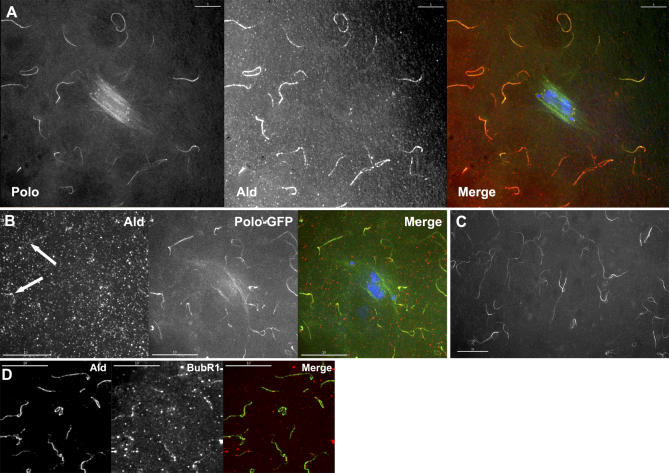
Polo and BubR1 Are Also Present in Ald-Containing Filaments(A) Polo-GFP/Ald colocalization A fixed oocyte from a polo-GFP homozygous female, showing that only Polo localizes along the meiotic tubulin spindle, while both Ald and Polo colocalize to kinetochores and along the cytoplasmic filaments. The chiasmate chromosomes appear slightly abnormal, possibly due to overexpression of Polo, but achiasmate X NDJ was no more than 1%–3% (our unpublished observations).(B) Polo-GFP still highlights filaments in ald mutant oocytes. A fixed oocyte from a polo-GFP/+; aldExc23 female. This ald allele greatly reduces, but does not eliminate, the dosage of wild-type Ald present (see Figure 5B). Ald staining is mostly in discrete foci, some of which are close enough together to be interpreted as filaments (arrows). However these filaments still contain Polo-GFP fluorescence, which appears undisturbed by the reduction in Ald dosage.(C) Unfixed Polo-GFP also highlights filaments GFP fluorescence from an unfixed polo-GFP oocyte, with filaments qualitatively similar to those seen in fixed images. Due to the lack of a DNA marker, the location of these filaments relative to the oocyte nucleus could not be determined, but based on Polo-GFP localization to the spindle (see Figure 6A), the oocyte nucleus does not appear to be in the imaged region.(D) BubR1 can also highlight filaments. In ten out of 33 FM7/X oocytes, BubR1 was found to weakly highlight some filaments visualized by Ald antibody. This figure represents the best staining observed; in most oocytes the staining was weaker (but still detectable) and only present in a subset of filaments.